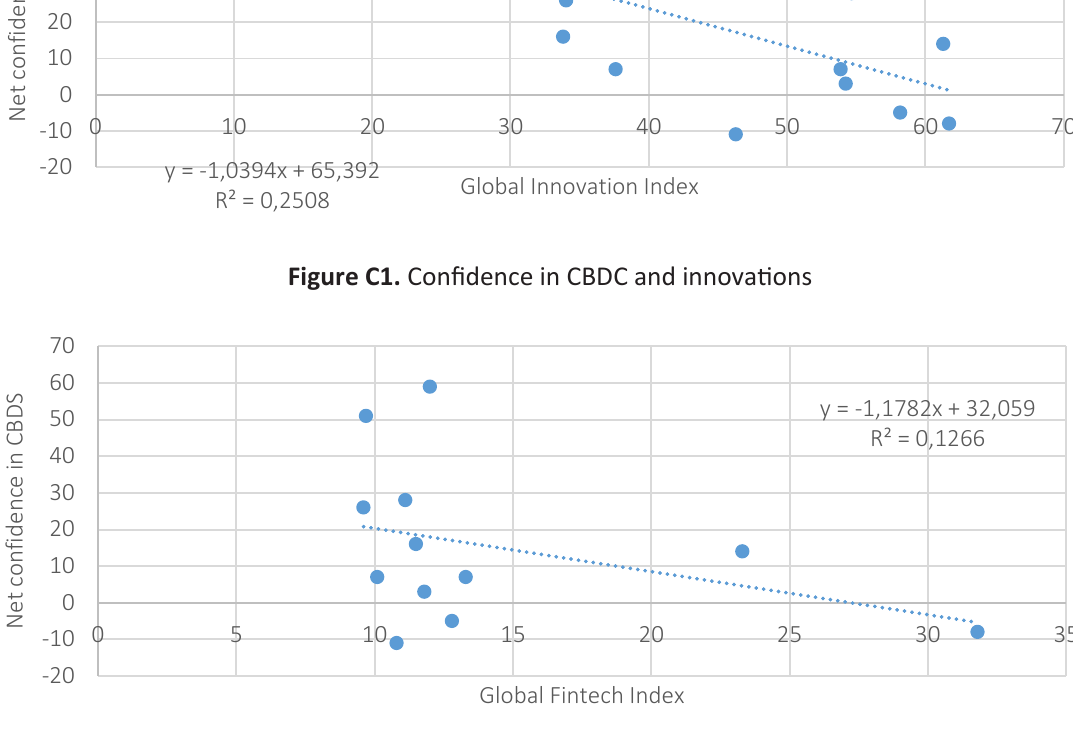
Figure С2. Confidence in CBDC and FinTech